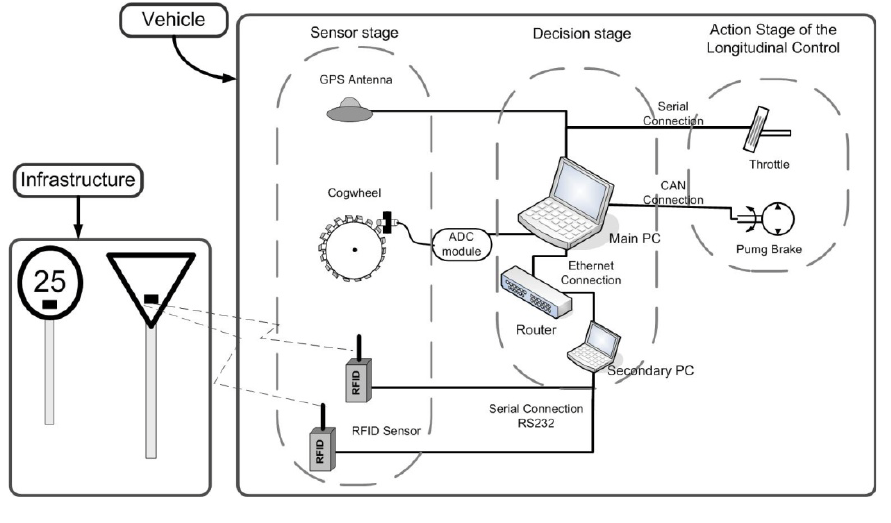
Figure 4. Control scheme onboard the vehicle and its interaction with the